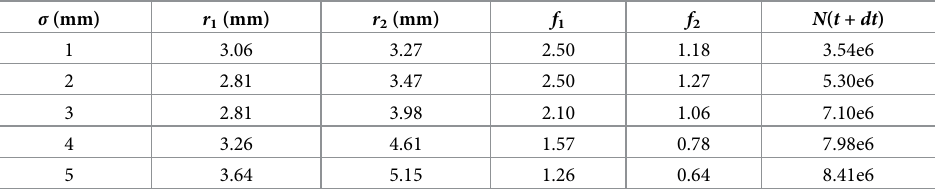
Table 3. One fraction & two radial steps.